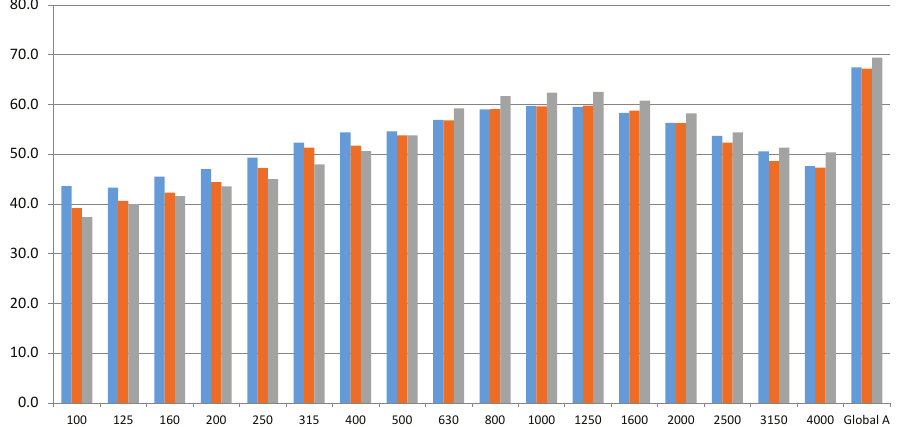
Measured LA,eq,1h at 100 km/h (dBA) DEUFRABASE with measured spectrum (dBA) DEUFRABASE with mean spectrum (dBA)